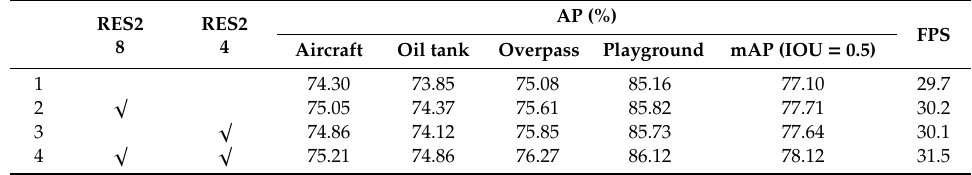
Table 12. The influence of ‘Res2 block’ on remote sensing target detection with three detection layers. RES2